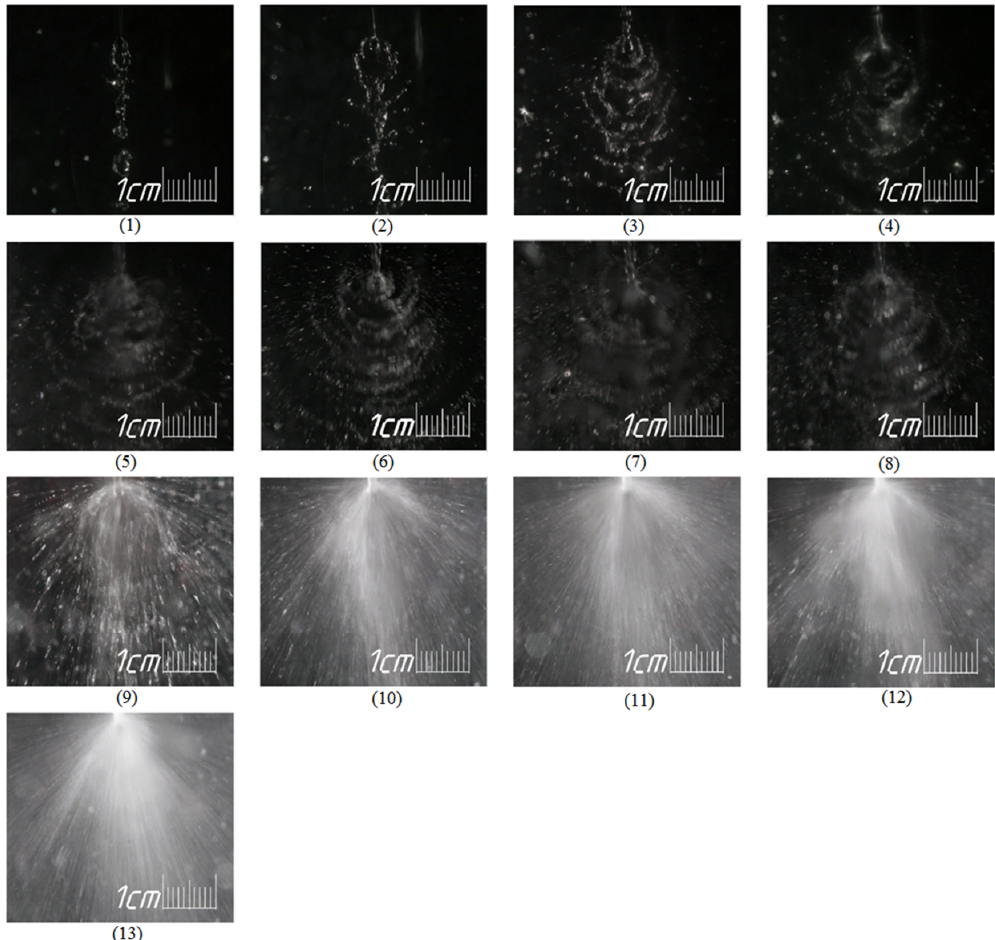
Figure 5. Photo of liquid sheet in the open-frame MRFIJ at 2θ = 97.5°, d j = 1.0 mm, T = 21 °C. Flow rate of water from each nozzle, ml/min: (1)–100, (2)–200, (3)–300, (4)–400, (5)–500, (6)–600, (7)–800, (8)– 1000, (9)–1200, (10)–1400, (11)–1600, (12)–1800, (13)–2000.